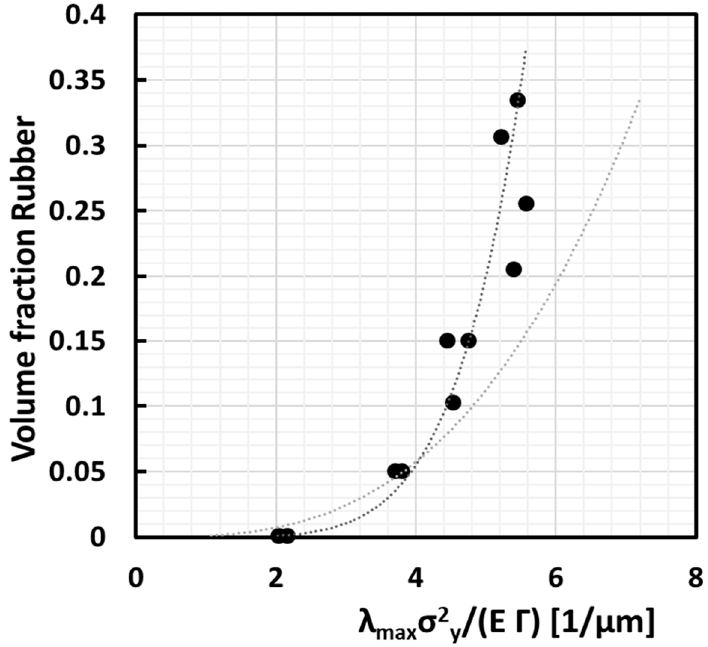
Figure 13. Proportionality of volume fraction of rubber with critical ligament size in arbitrary units, according to the model in this paper, assuming cubic stacking of monodisperse rubber particles with size 1.44 µ m. Black curve is the fit with experimental data, which scales with exponent 5.3; grey curve illustrates the third power scaling.